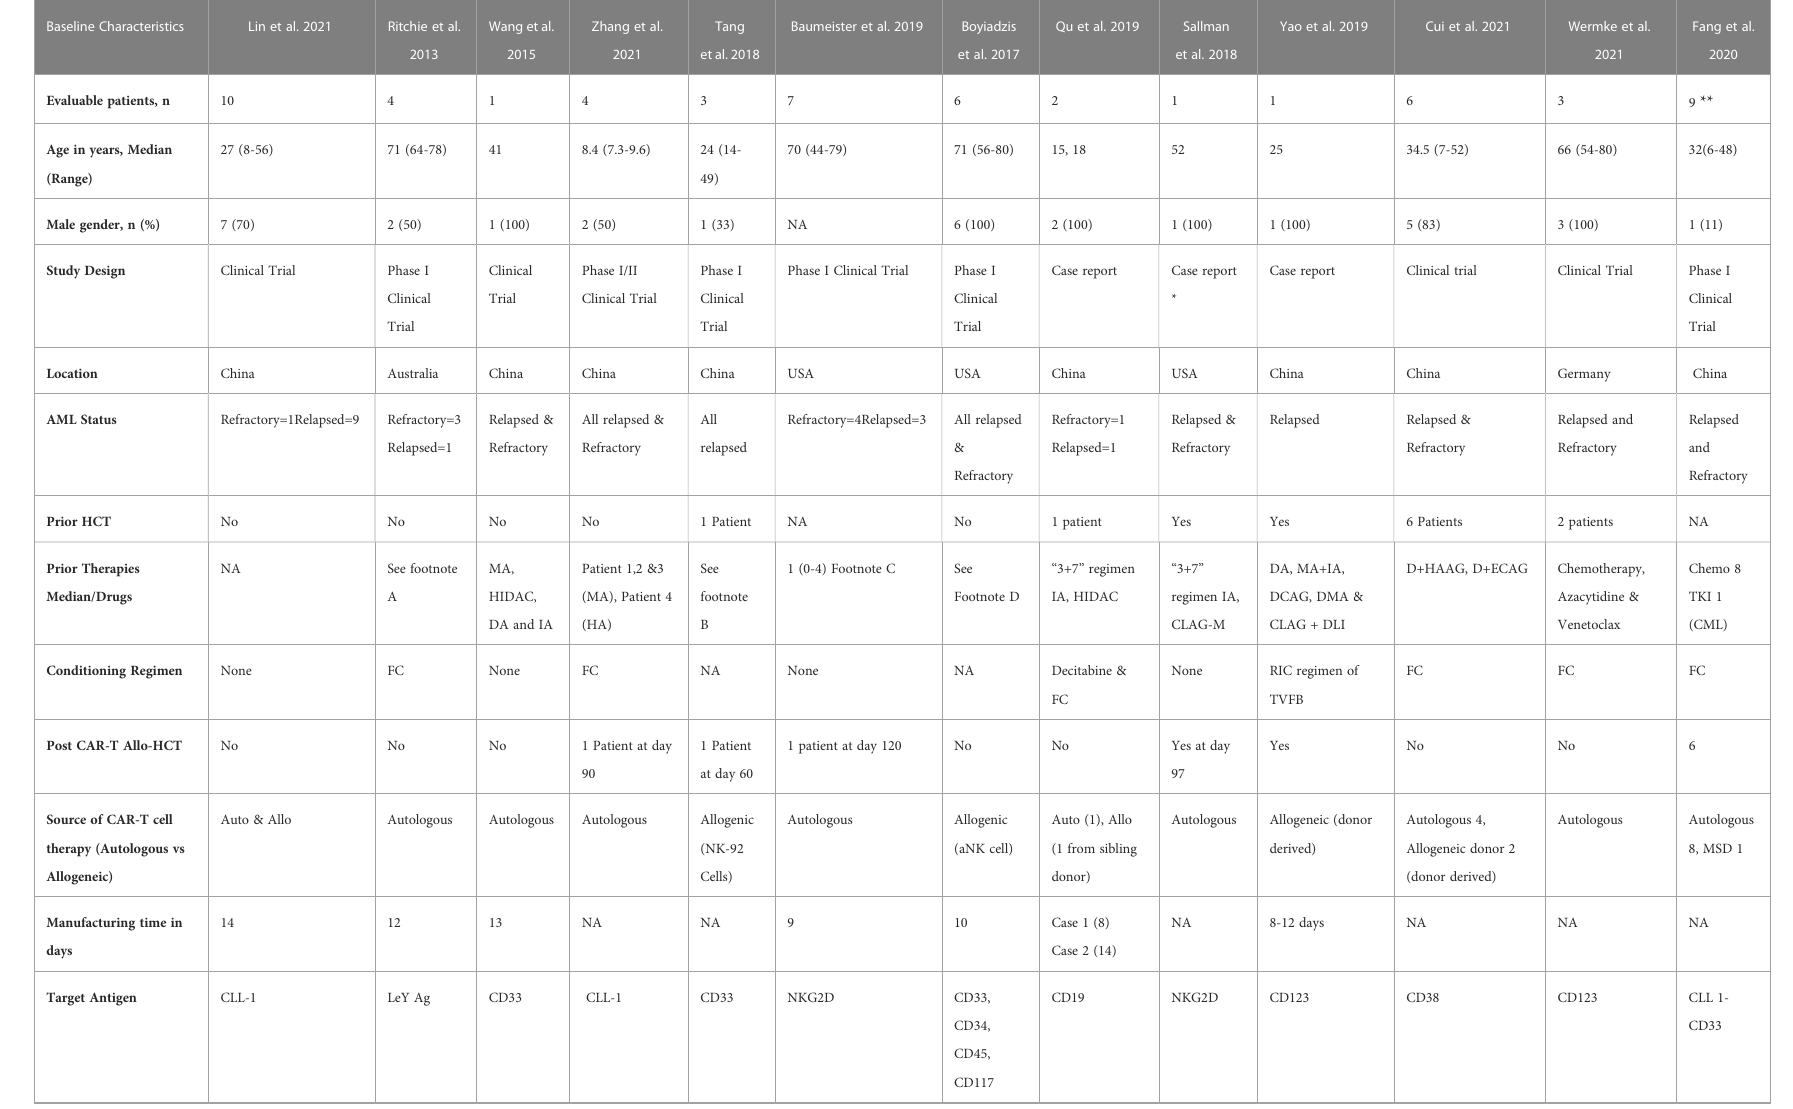
TABLE 1 Baseline Characteristics of chimeric antigen receptor T-Cell (CAR-T) therapy in acute myeloid leukemia (n=57).